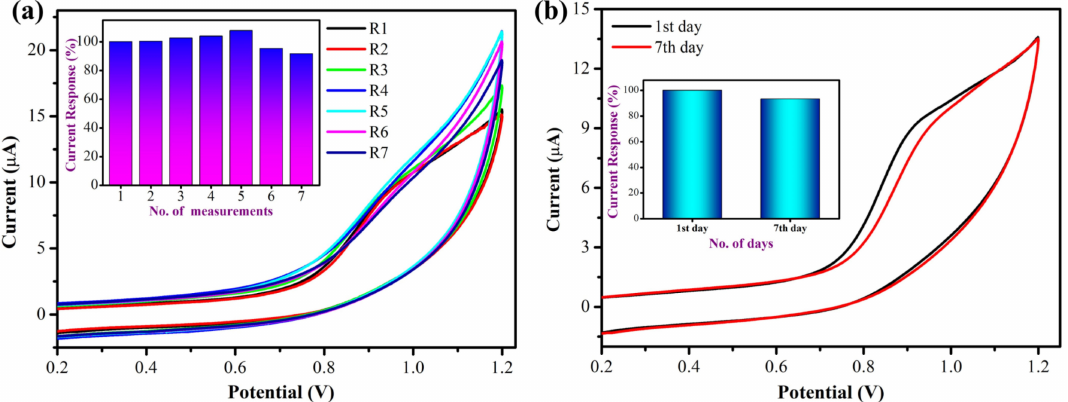
Figure 14. ( a ) Repeatability measurements of 300 µ M NIC using a same MXene/PHC/GCE up to seven repeated measurements in 0.1 M phosphate buffer (Inset shows the bar graphs of No. of measurements vs. NIC oxidation peak current response of each measurement). ( b ) The stability of the MXene/PHC/GCE towards the oxidation of 300 µ M NIC in 0.1 M phosphate buffer (Inset: bar diagram shows current responses of NIC vs. no. of